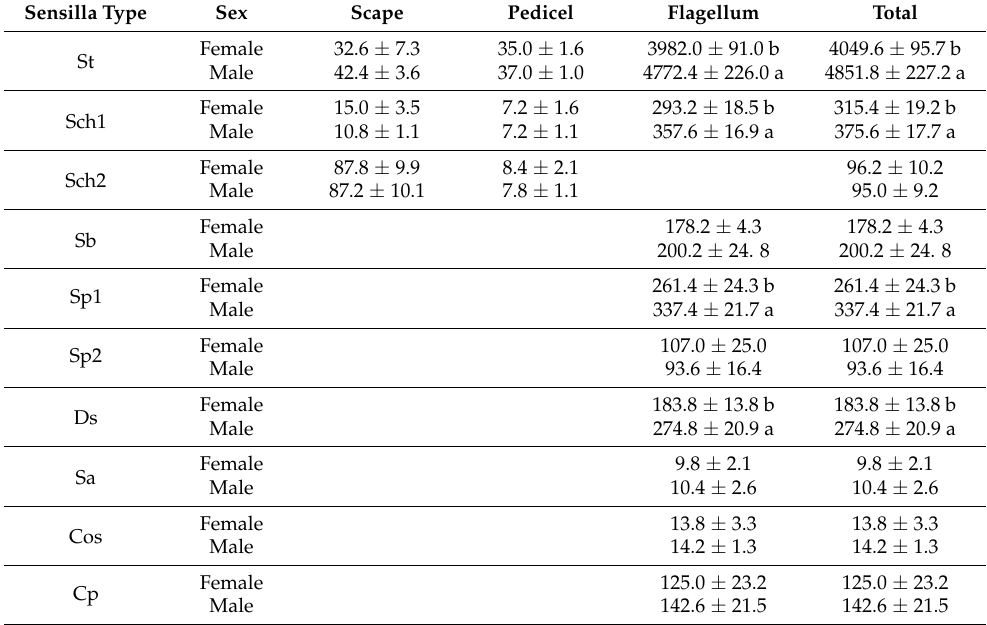
Table 3. Number and distribution of different types of sensilla on the antennae of female and male C. qinlingensis